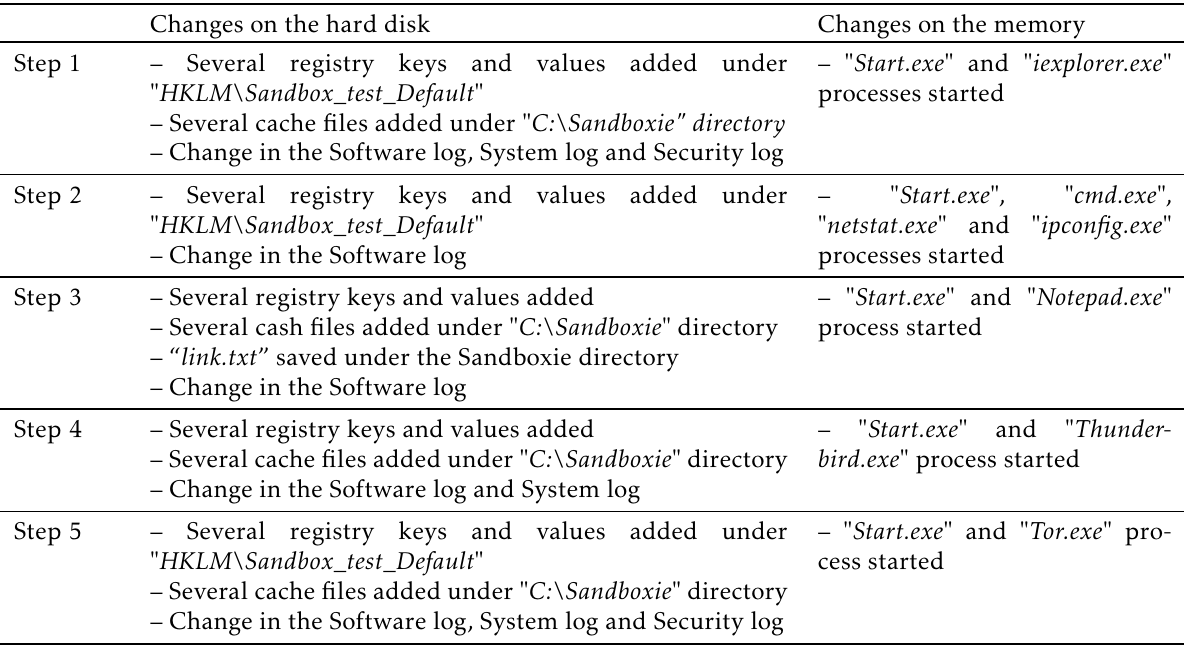
Table 3. System changes from generating user data in experiment setup within Sandboxie